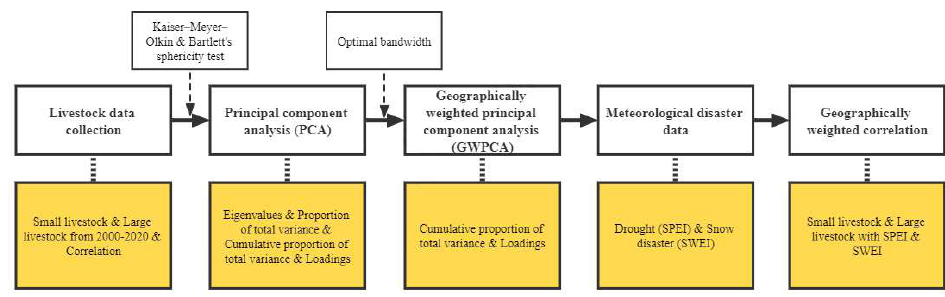
Figure 3. Data processing